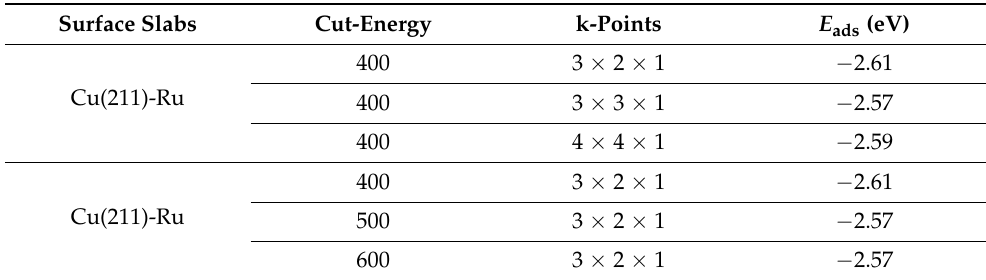
Table 6. Model testing parameters for COOH adsorption on the Cu(211)-Ru surface. Surface